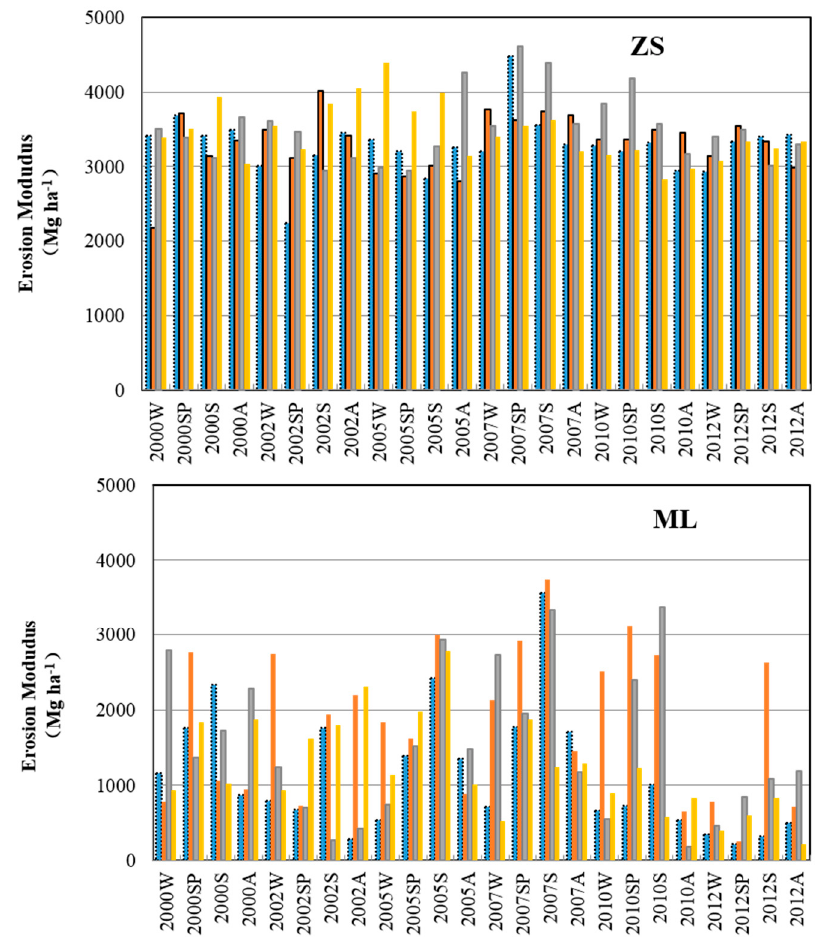
Figure 2. Tendency of erosion modulus within each region between 2000 and 2012 (W: winter; SP: spring; S: summer; A: autumn).